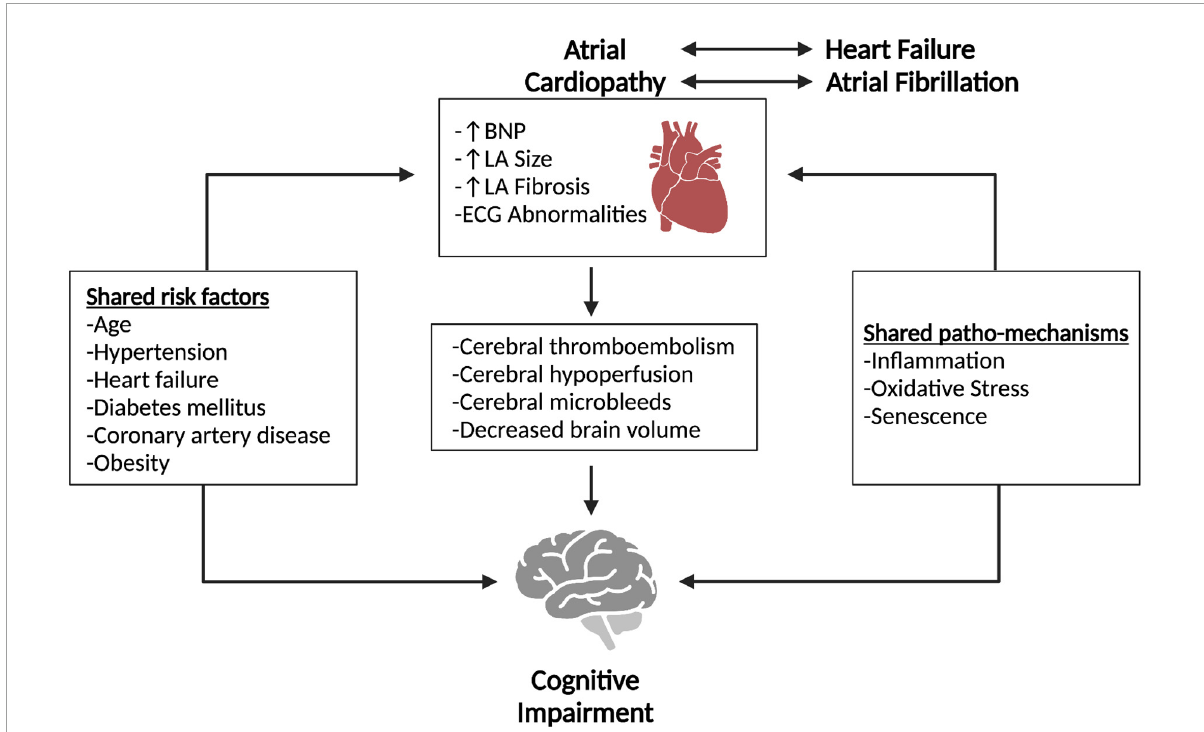
FIGURE1 Overview of proposed relationship between atrial cardiopathy and cognitive impairment. Atrial cardiopathy, atrial fibrillation and heart failure all share multiple risk factors and patho-mechanisms with cognitive impairment. The effects of atrial cardiopathy potentially predispose individuals to cognitive impairment. Pathways that lead from atrial cardiopathy to cognitive impairment may include cerebral thromboembolism, hypoperfusion, microbleeds, and brain volume loss. Created with Biorender.com.